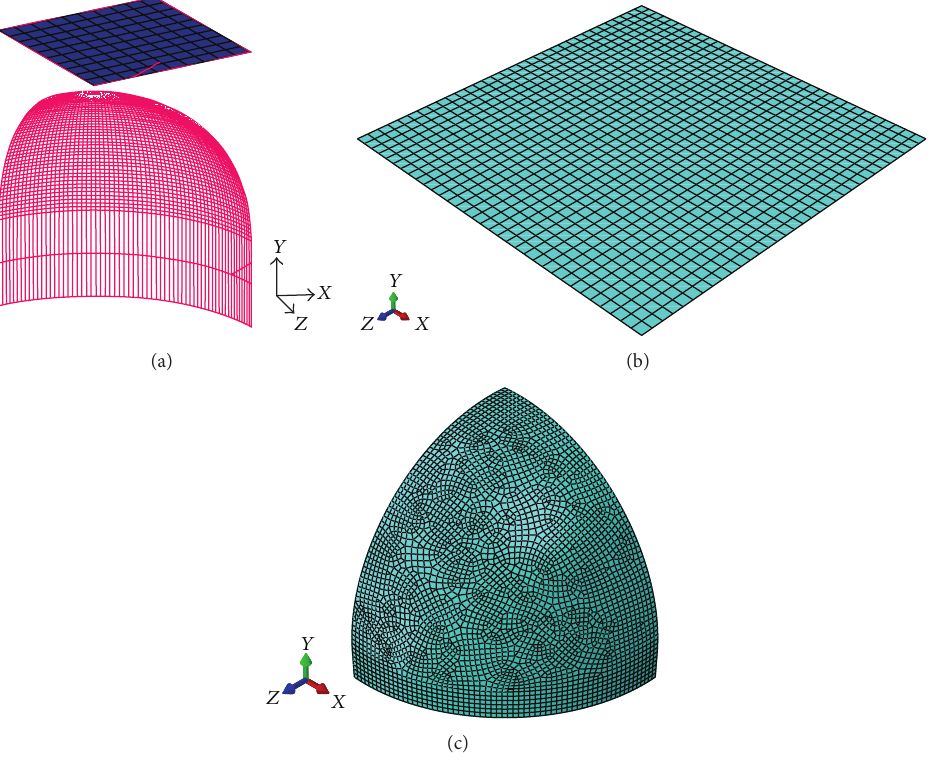
Figure 14: (a) Finite element mesh for punch and sheet in MSC-MARC. (b) Finite element mesh for the sheet in Abaqus. (c) Finite discrete rigid element mesh for the punch in